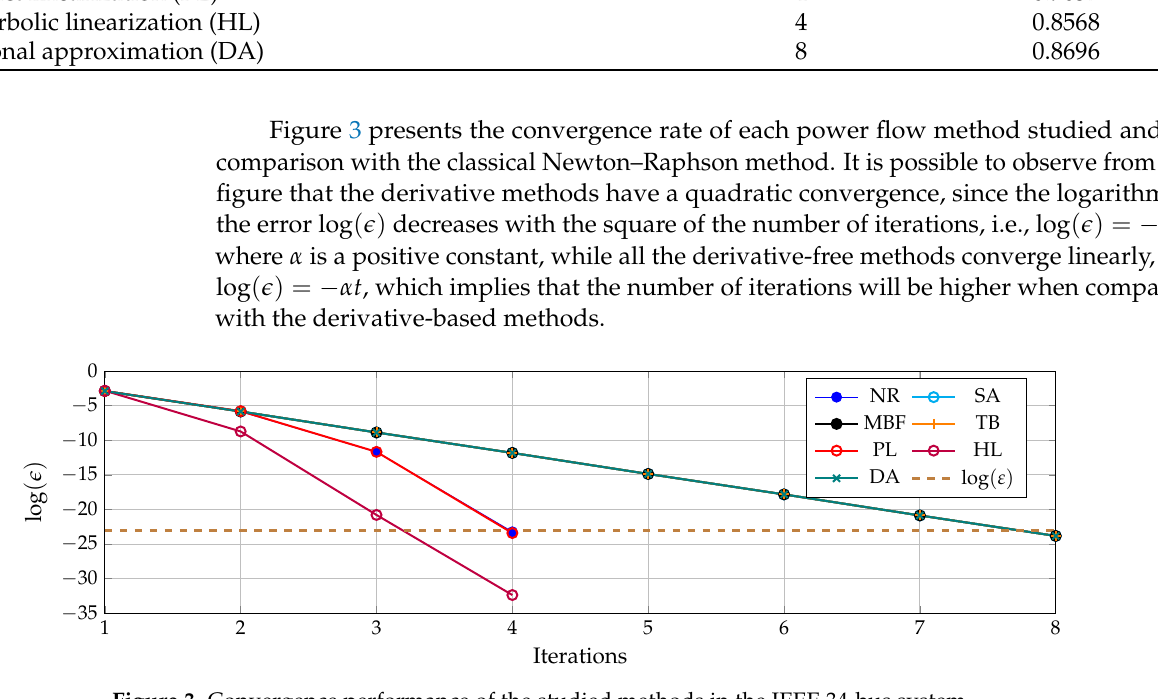
Figure 3. Convergence performance of the studied methods in the IEEE 34-bus